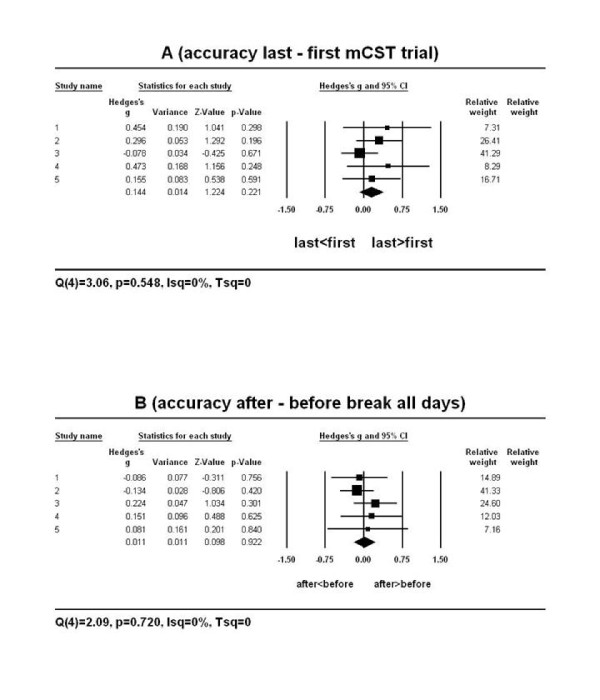
The forest plot of the random-effects meta-analysis on the mean ACCURACY of performance on the last vs. the first mCST trial (A) and after vs. before the session break on all experimental days (B). Positive effect sizes (Hedges' g represented as boxes on the plot) indicate an improvement while negative effect sizes indicate a decline in accuracy of performance on the last vs. the first mCST trial or after vs. before the break. The 95%C.I. of all five effect sizes (the horizontal lines through the boxes) overlapped with zero. The mean weighted effect sizes g (the centre of each diamond in A and B) were small and their 95%C.I. (the edges of the diamonds) overlapped with zero. Therefore, there was no change in the mean accuracy of performance in the long-term (last vs. first mCST trial; A) or the short-term (after vs. before the session break; B). The relative weights indicate that the study 3 in A and the study 2 in B had the highest contribution to the computation of the mean weighted effect sizes.